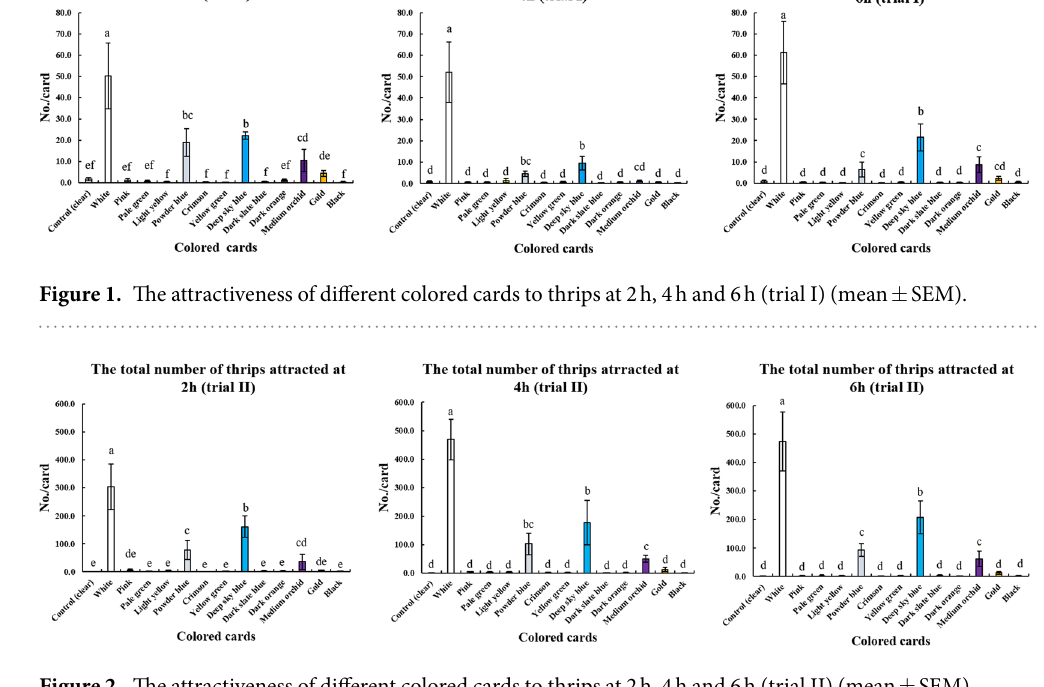
Results Effect of card color on thrips.